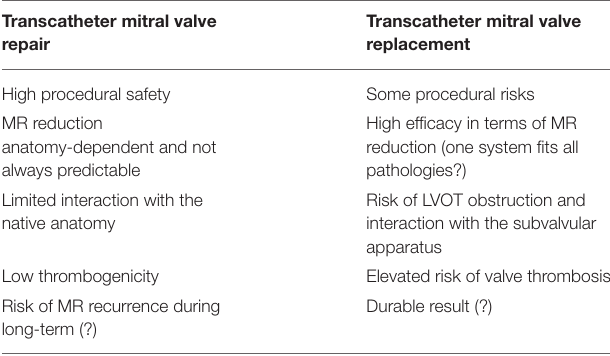
TABLE 2 | Advantages and disadvantages of transcatheter mitral valve repair and